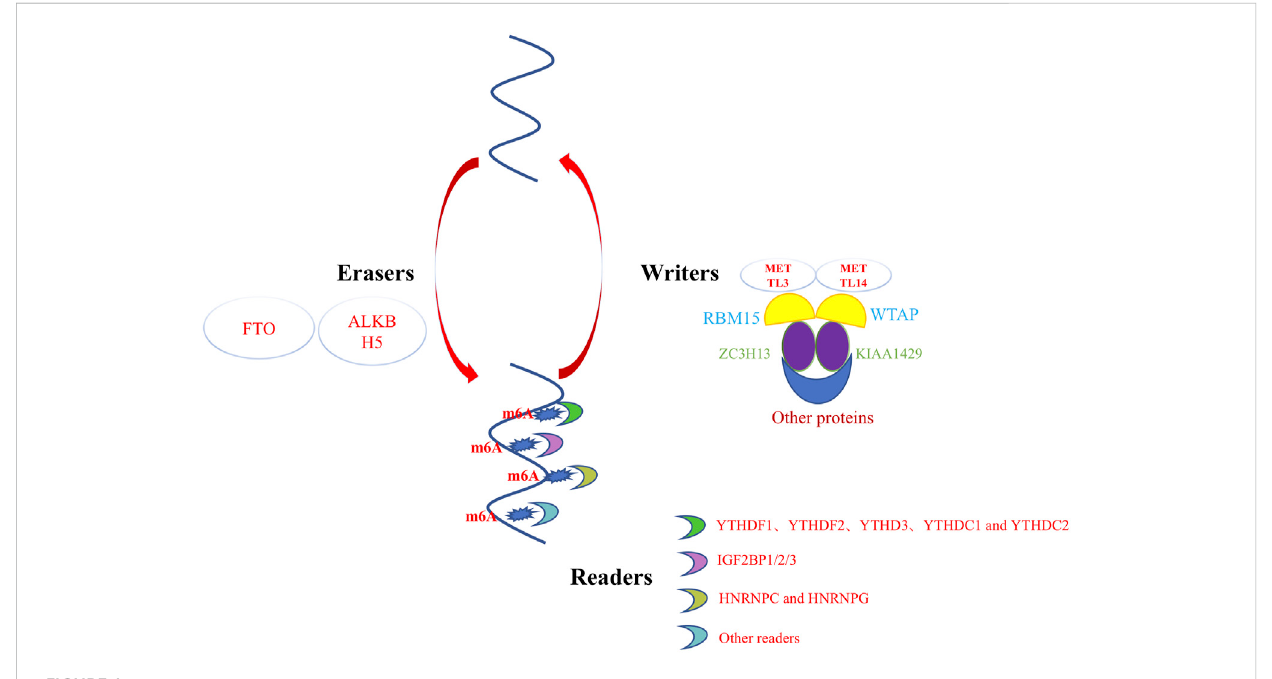
FIGURE 1 m6A methylation is dynamic regulated by writers, erasers, and readers.